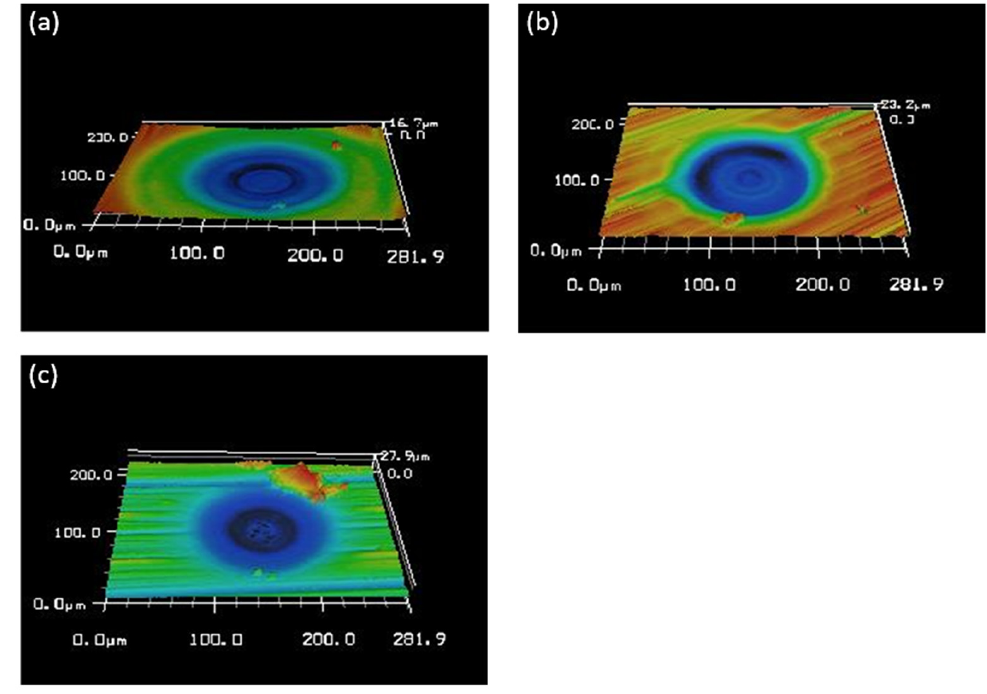
Figure 8. ECM drilling performance of pulse on-time T ON : ( a ) 0.1 ms, ( b ) 0.2 ms, ( c ) 0.4 ms.